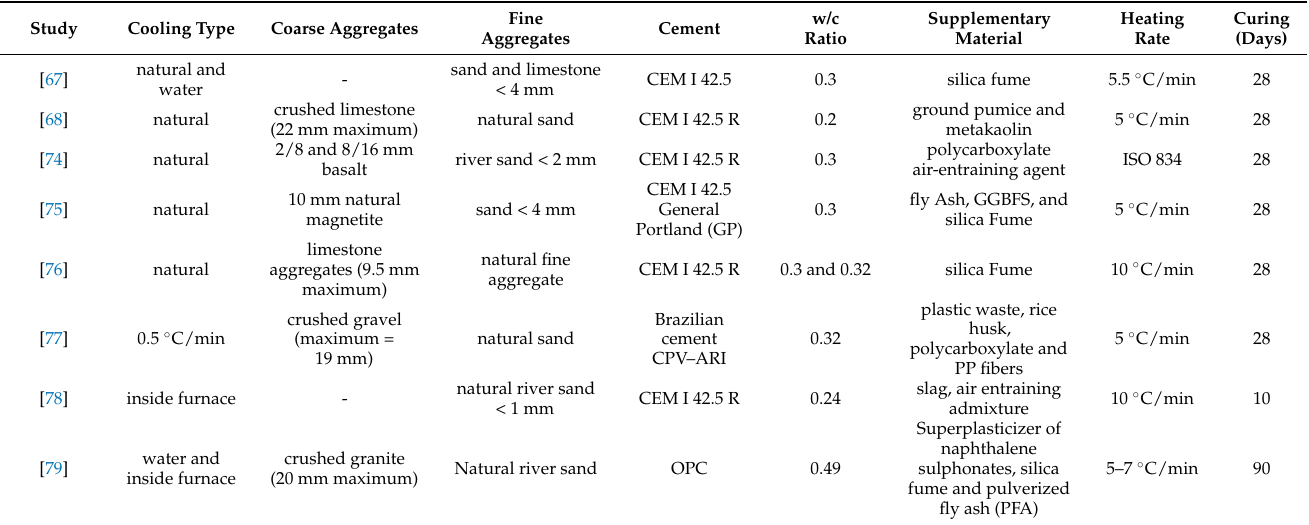
Table 3. Important parameters of different studies on HSC